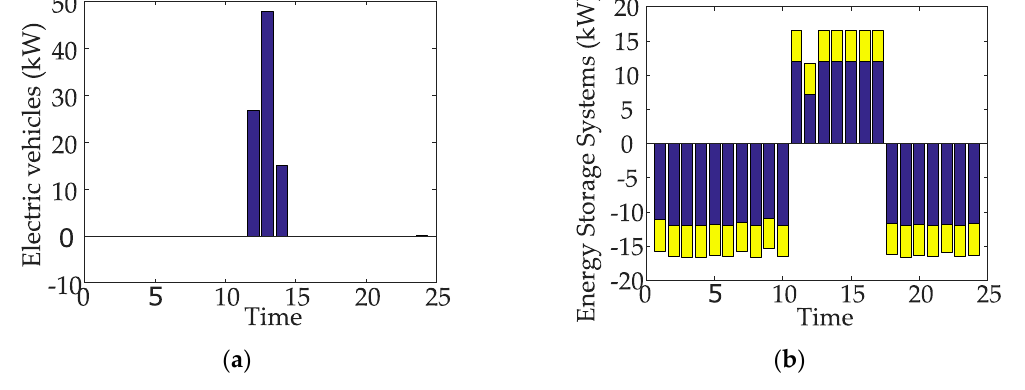
Figure 4. Discharge and charge: ( a ) EVs; ( b ) ESS.